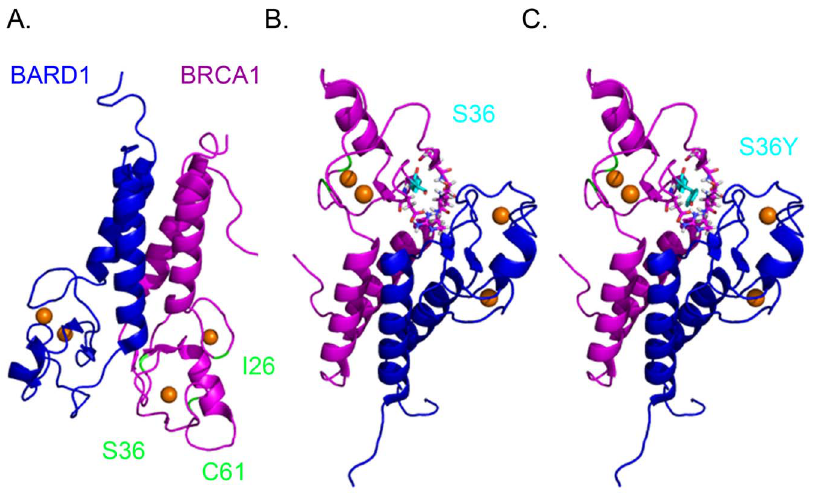
Figure 6. Ribbon representation of the BARD1:BRCA1 complex. A. The RING domains of BRCA1 and BARD1 (PDB 1JM7 [63]) are represented in magenta and blue respectively and the residues isoleucine 26, serine 36 and C61G are indicated in yellow. Orange spheres represent the Zn 2 + ions. This model demonstrates that serine 36 lies within the second b -sheet of the RING structure. B. and C. represent the complex in a different orientation revealing the position of serine 36 (B.) and its substitution by tyrosine (C.) may distort the structure. The model was modified using PyMOL software.